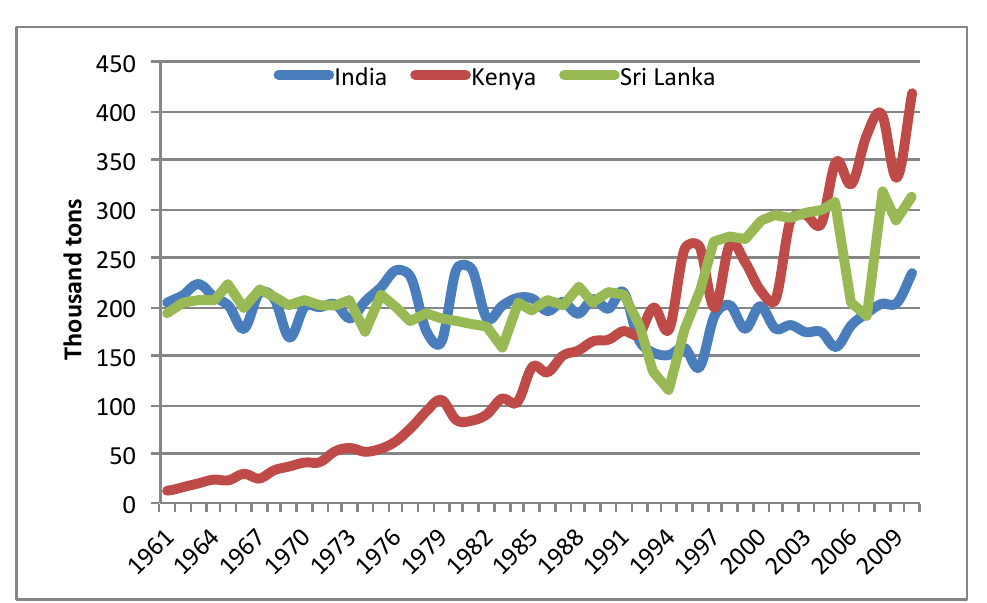
Figure 2. Trends in tea exports (thousand tons) by the three largest black tea exporters. Source: